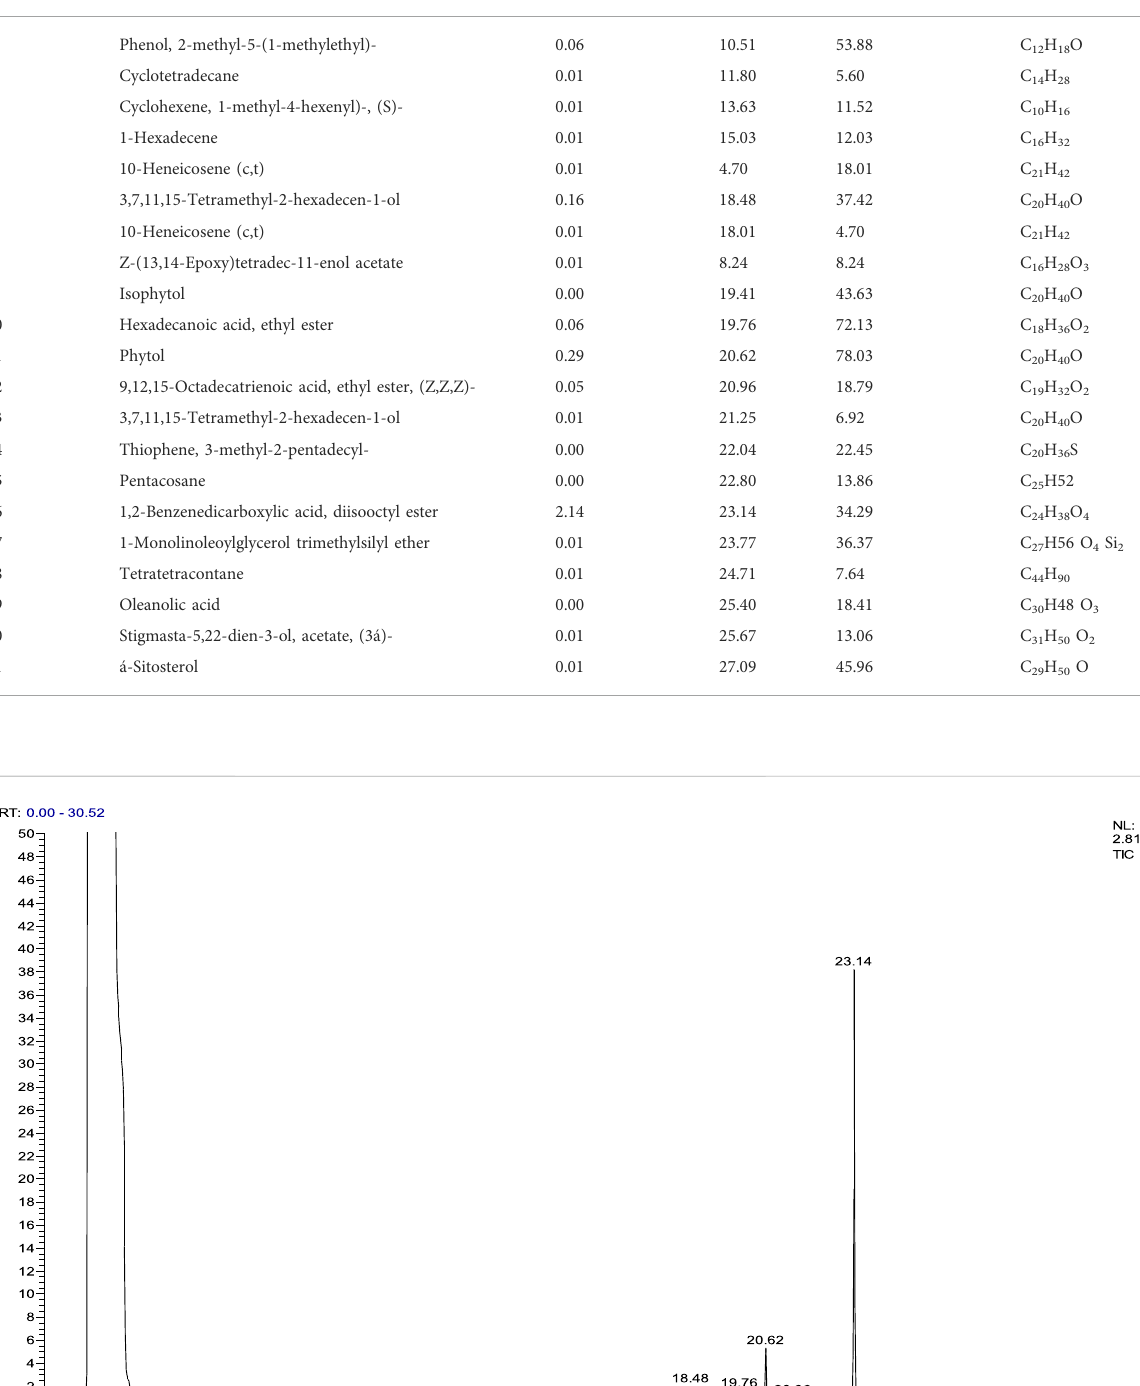
TABLE 3 List of phytochemicals identi fi ed in the ethyl acetate fraction of Justicia adhatoda through the gas chromatography – mass spectrometry approach. S. no.